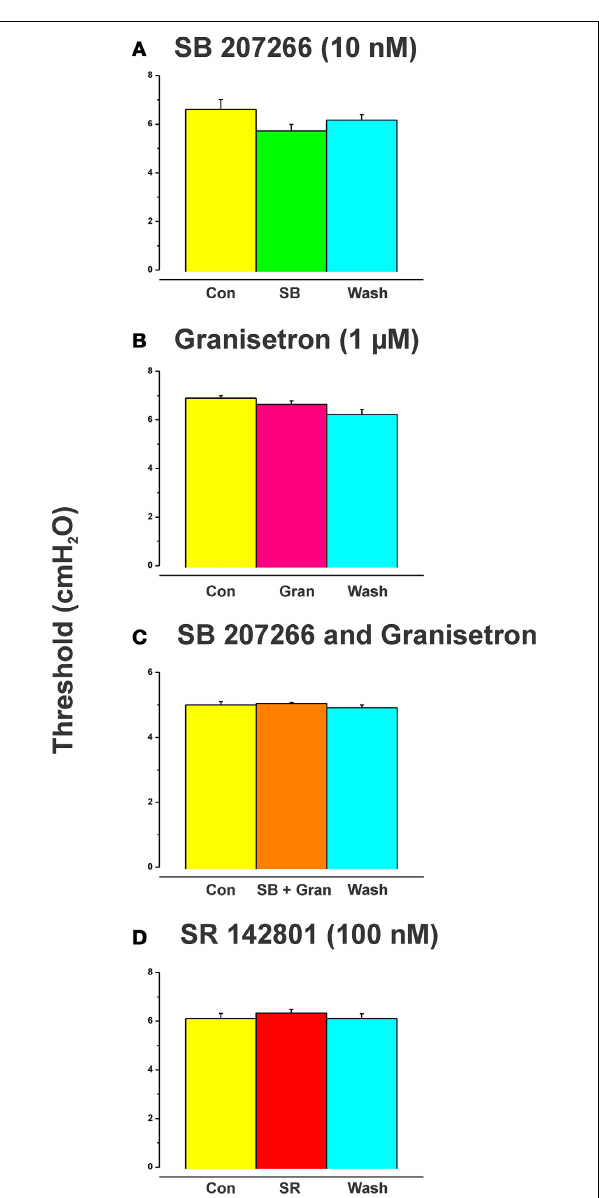
FIGURE 4 | Effects of blockade of 5-HT 4 , 5-HT 3 , and NK 3 receptors on the threshold for initiation of propulsion in the absence of other drugs. SB 207266 and granisetron when added to the luminal perfusate on their own, or in combination, had no effect on the threshold pressure for initiation of propulsive contractions (A–C) . The specific NK 3 tackykinin receptor antagonist SR 142801 (100nM) also had no effect on the threshold pressure for propulsive contractions (D)